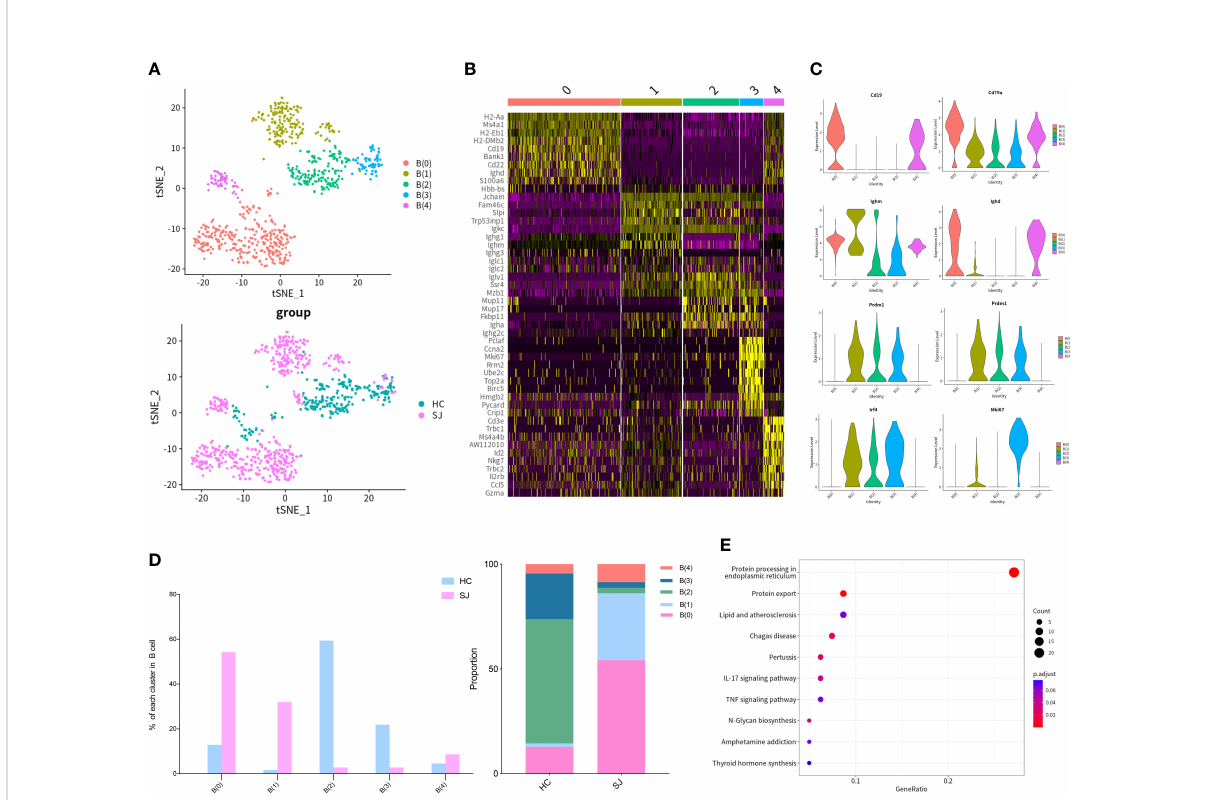
FIGURE 4 B cells in fi brotic liver of schistosomiasis japonica. (A) tSNE plots of the 769 B cells for fi ve clusters and two groups. (B) Heatmap of B cells for the top 10 DEGs of each cluster. (C) Violin plots of genes in each B cells cluster. (D) The percentage change tendency and contribution of each B cells cluster in two groups. (E) Bubble plots of KEGG pathway enrichment DEGs between B(1) and other B cells